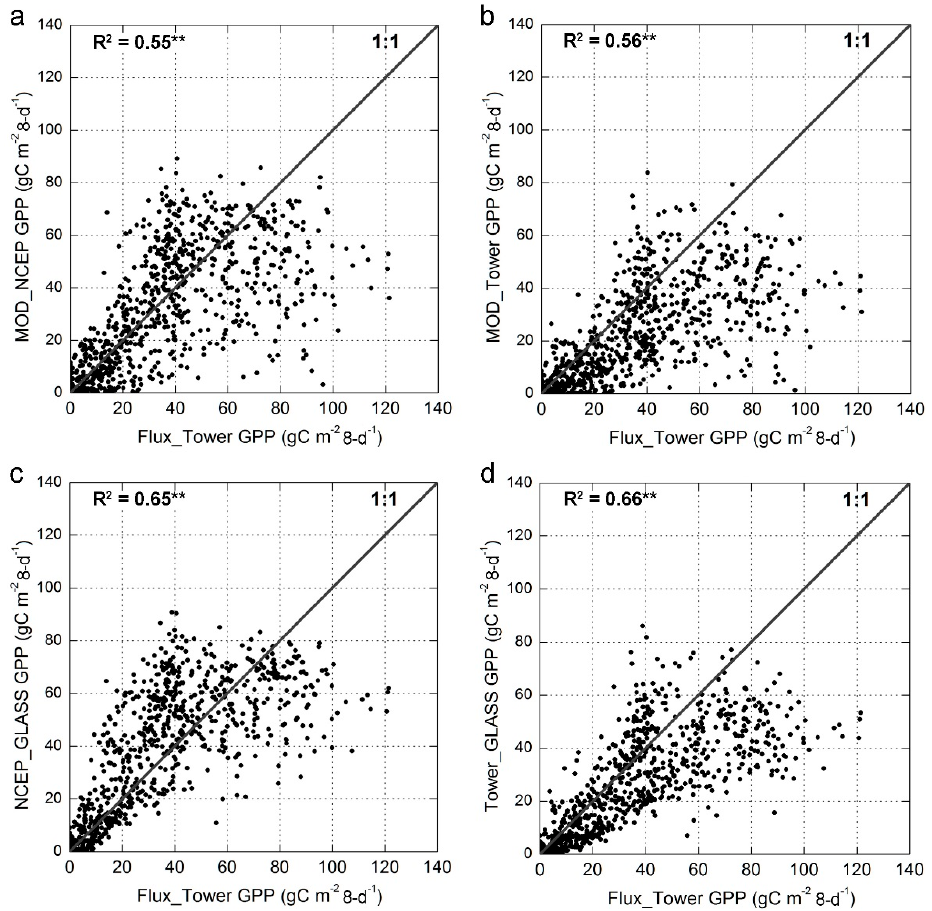
Figure 2. ( a ) Scatter plots of the eight-day MOD_NCEP GPP vs. the Flux_Tower GPP; ( b ) MOD_Tower GPP vs. the Flux_Tower GPP; ( c ) NCEP_GLASS GPP vs. the Flux_Tower GPP; and ( d ) Tower_GLASS GPP vs. the Flux_Tower GPP. Significance levels: ** p <